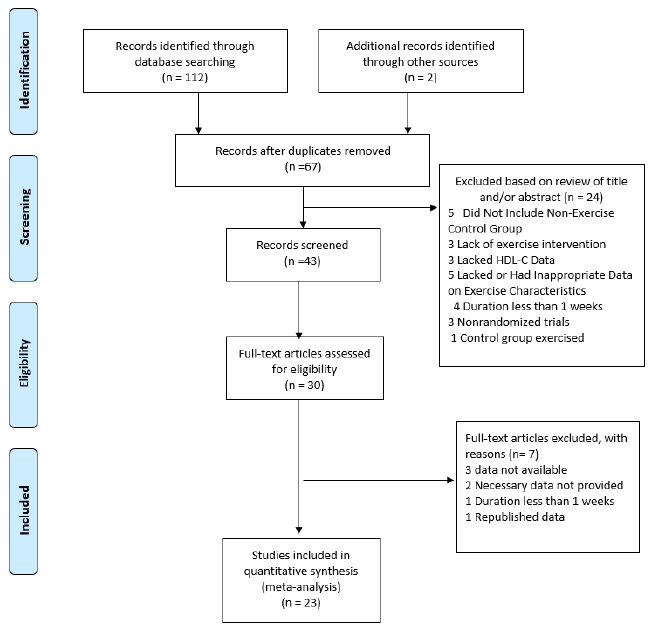
Figure 1. Flow chart of the study selection procedure.